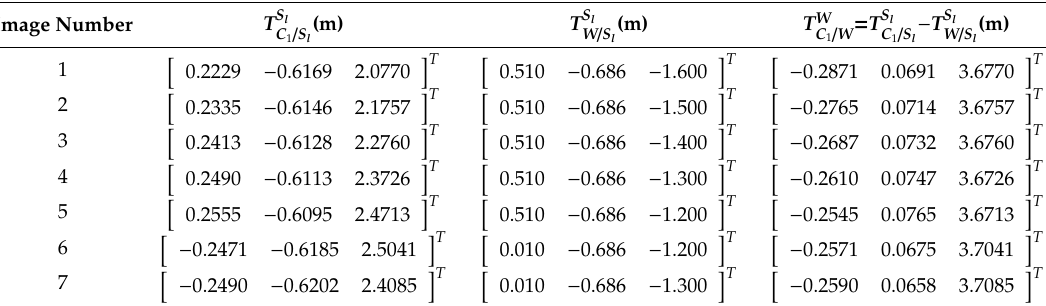
Table 4. Translation vectors from the C 1 system to the W